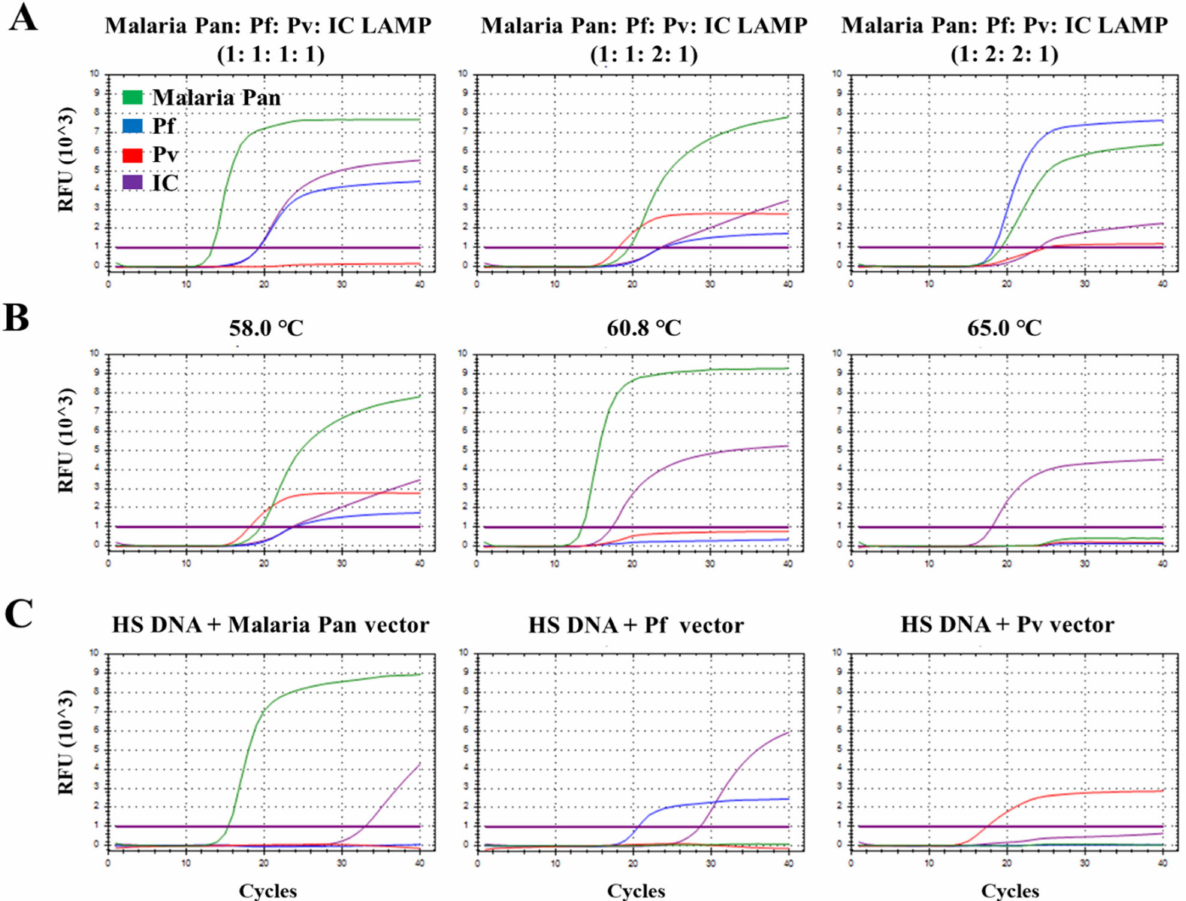
Figure 1. Optimization of the multiplex malaria Pan/Pf/Pv/IC LAMP primer set. ( A ) Different concentration ratios of the malaria Pan, Plasmodium falciparum , Plasmodium vivax , IC primer sets (1:1:1:1, 1:1:2:1, and 1:2:2:1, respectively) for malaria Pan, P. falciparum , P. vivax , and IC vectors. ( B ) Temperature gradient tests (58/60.8/65 ◦ C) of the multiplex malaria Pan/Pf/Pv/IC LAMP assay. ( C ) Performance of malaria Pan/Pf/Pv/IC LAMP assay against HS DNA spiked with malaria pan vector, HS DNA spiked with P. falciparum vector, and HS DNA spiked with P. vivax vector . IC, internal control; LAMP, loop-mediated isothermal amplification. The color of the curves is the same in all panels and the meaning of curve colors is indicated in Panel